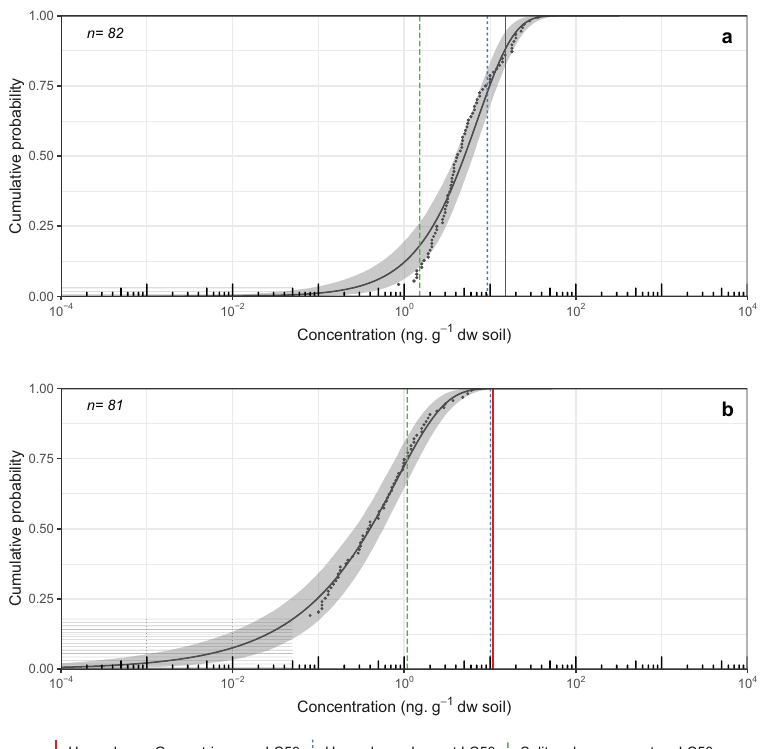
Figure 4. Environmental Exposure Distribution (EED) for acute exposure to ( a ) clothianidin and ( b ) thiamethoxam in soil from field crops (corn, soybeans, wheat) based on a government dataset 13 . Soil samples were taken from 0–15 cm depth in southern Ontario, 2016. Effects benchmark concentrations are for solitary ground-nesting bees based on the hoary squash bee ( Peponapis pruinosa ) acute exposure amounts (48 h, 2.23 g soil). Effect benchmarks (i.e. honey bee geometric mean LC 50 = red vertical line, honey bee lowest LC 50 = blue vertical dotted line, and the solitary bee surrogate LC 50 = green vertical dashed line) are represented on the EED. Exceedance of these endpoints is calculated by subtracting the cumulative probability from one. Grey horizontal lines represent individual soil samples below the analytical limit of detection, and black dots indicate samples for which insecticide residues could be quantified. The black line indicates the line of best fit to the data via maximum likelihood estimation (MLE) with associated 95% confidence intervals (grey